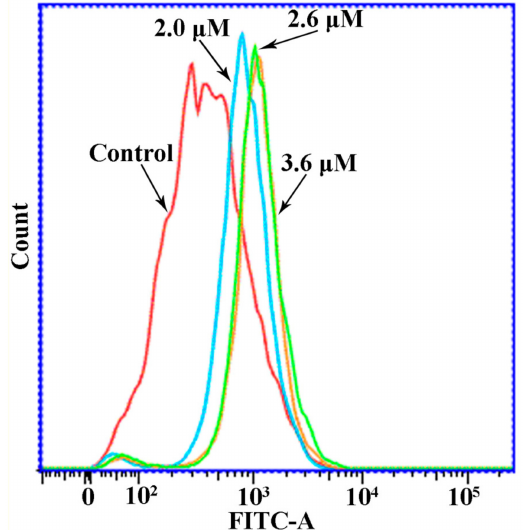
Figure 9. The ROS generation assay by flow cytometry analysis of MGC80-3 cells treated with complex 1 (2.0, 2.6, and 3.6 µ M). Results are expressed as relative fluorescent intensities (from left to